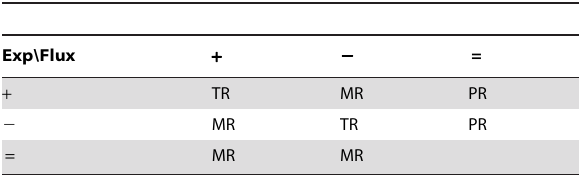
Table 4. Decision table to assign transcriptional regulation (TR), post transcriptional regulation (PR) or metabolic regulation (MR) to the different enzymes depending on the observed up-regulation ( + ), down-regulation ( 2 ) or lack of change ( =) of flux and gene